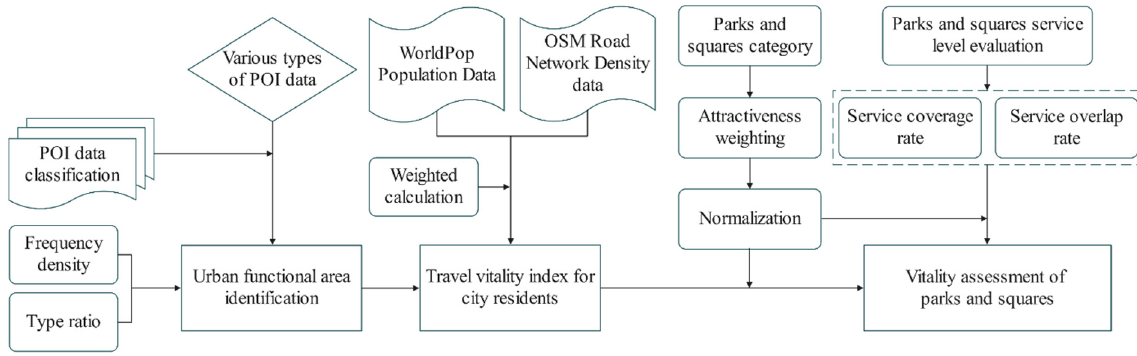
Figure 4. The framework for our study on park and square